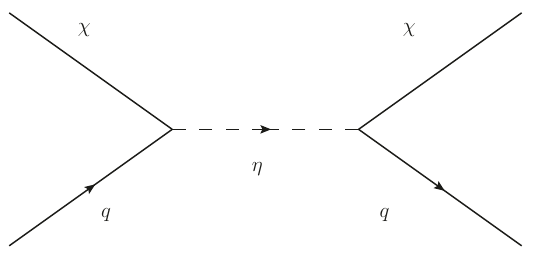
Figure 3 . Representative diagram contributing to the e(cid:11)ective DM nucleon interaction via tree- level (cid:17)